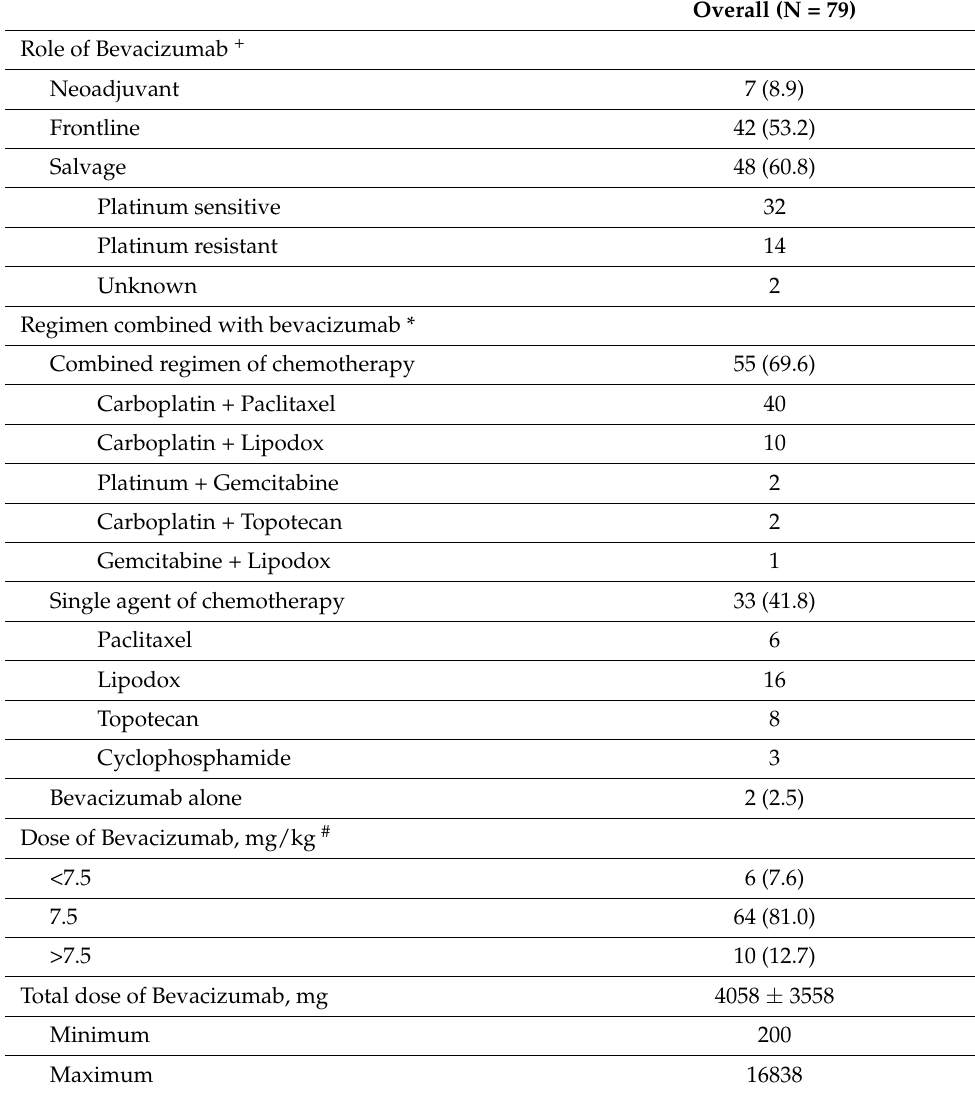
Table 2. Details of patients treated with